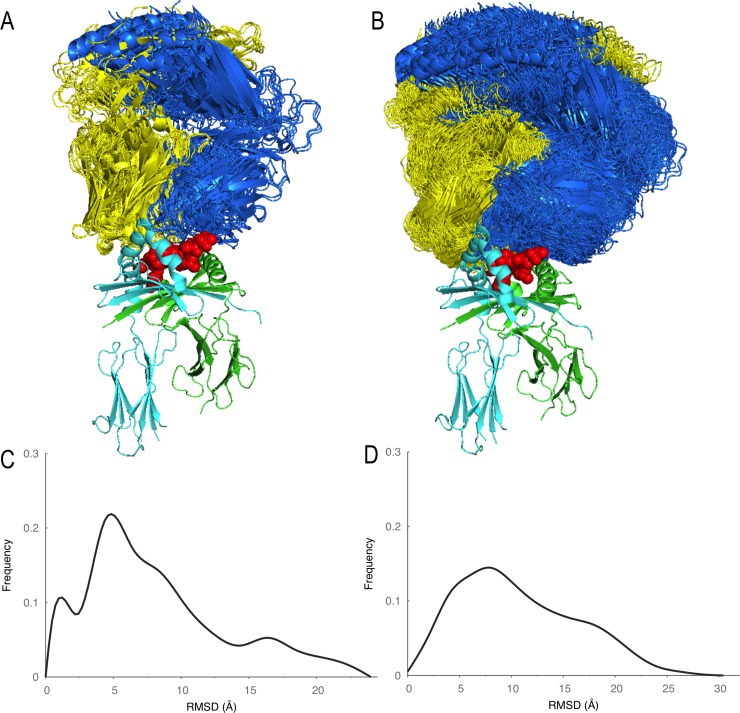
A) Orientations of TCRs with respect to MHCII in the 20 benchmark complexes. B) Orientations of TCRs with respect to MHCII in the 500 template structures generated by docking. C) Distribution of RMSD values between the 20 benchmark pMHCII-TCR structures. D) Distribution of RMSD values between the 500 template structures. Addition of docking generated templates resulted in better coverage of orientation space as indicated by the smoother RMSD distribution on the right.